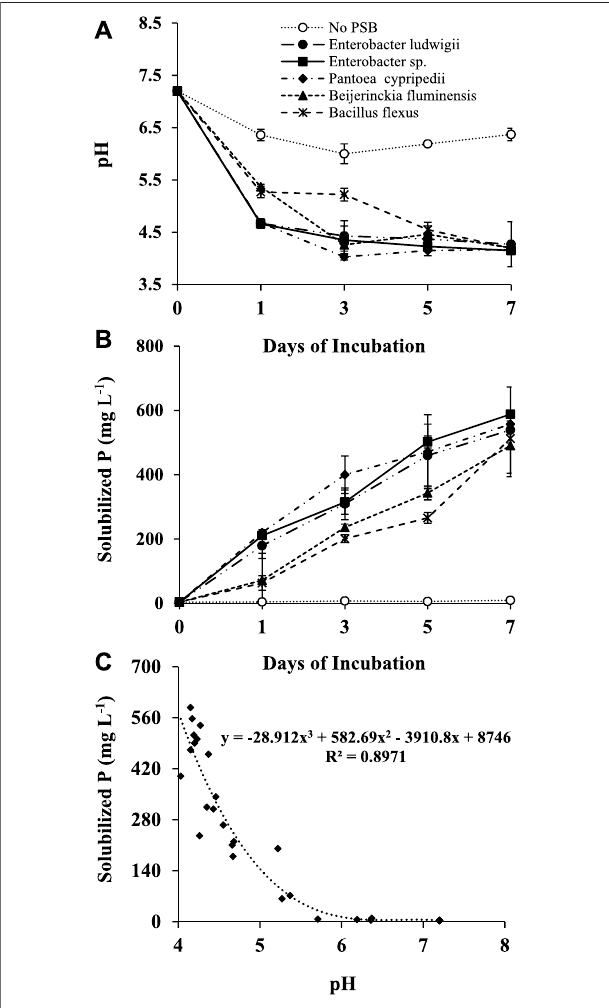
FIGURE 1 | Changes of pH (A) and solubilized phosphorus (B) and relationship between them (C) in NBRIP liquid medium during a week-long incubation. The error bars indicate the standard errors of the means ( n (cid:1)